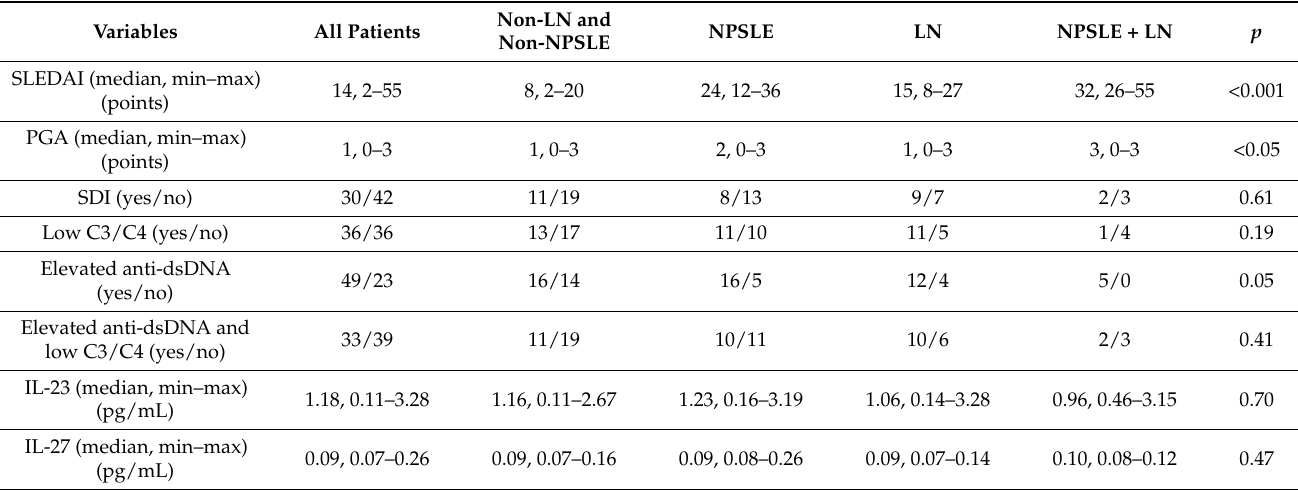
Table 2. Disease assessment, laboratory test results, and interleukin levels in the study group and neuropsychiatric lupus/lupus nephritis subgroups.